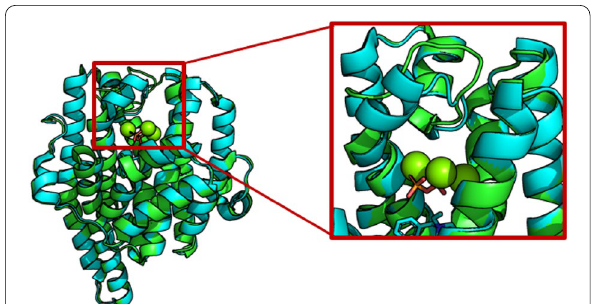
Fig. 11 Superposition of unliganded D99N epi ‑isozizaene synthase (PDB ID: 3LGK , green) and epi ‑isozizaene synthase complex with Mg,